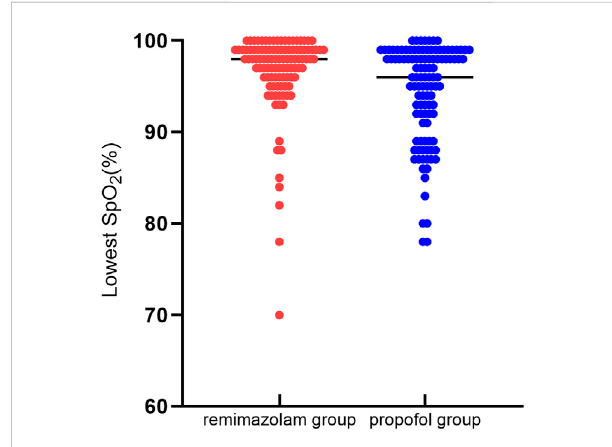
FIGURE 2 Lowest SpO 2 comparison. Distribution of the lowest intraoperative oxygen saturation values in 107 patients in the remimazolam group and 109 patients in the propofol group. Analysis by the Wilcoxon-Mann-Whitney test revealed a statistical difference between the two groups ( p <